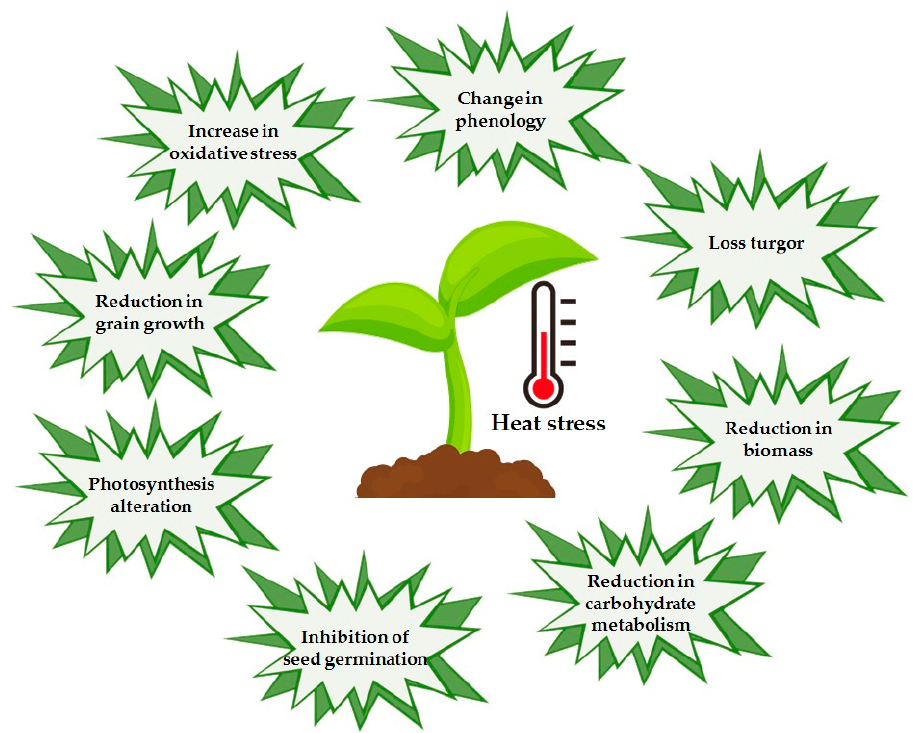
Figure 3. Some of the effects triggered by heat stress on plants. Heat stress causes physiological adjustments in plants. The photosynthetic apparatus